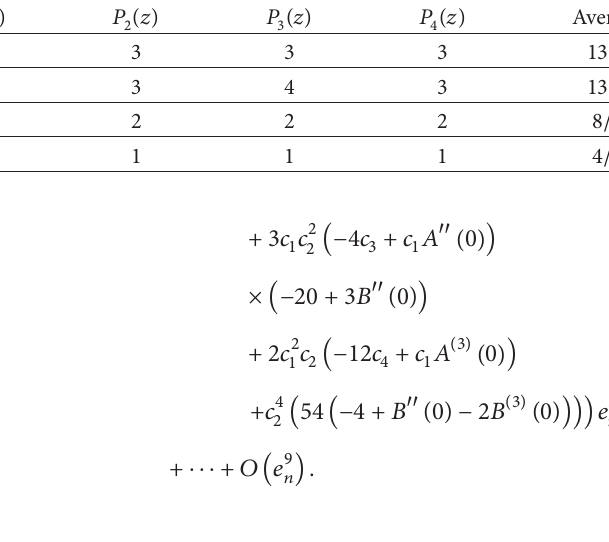
Table 4: Comparison of dynamical behavior of our proposed method (19) for different values of the parameters 𝛼 , 𝛽 , 𝛾 , and 𝛿 . Values of parameters Method 𝑃 1 (𝑧) 𝑃 2 (𝑧) 𝑃 3 (𝑧) 𝑃 4 (𝑧) Average 𝛼 = 1 , 𝛽 = −1 , 𝛾 = 1 , 𝛿 = 1 𝑂𝑀 8,1